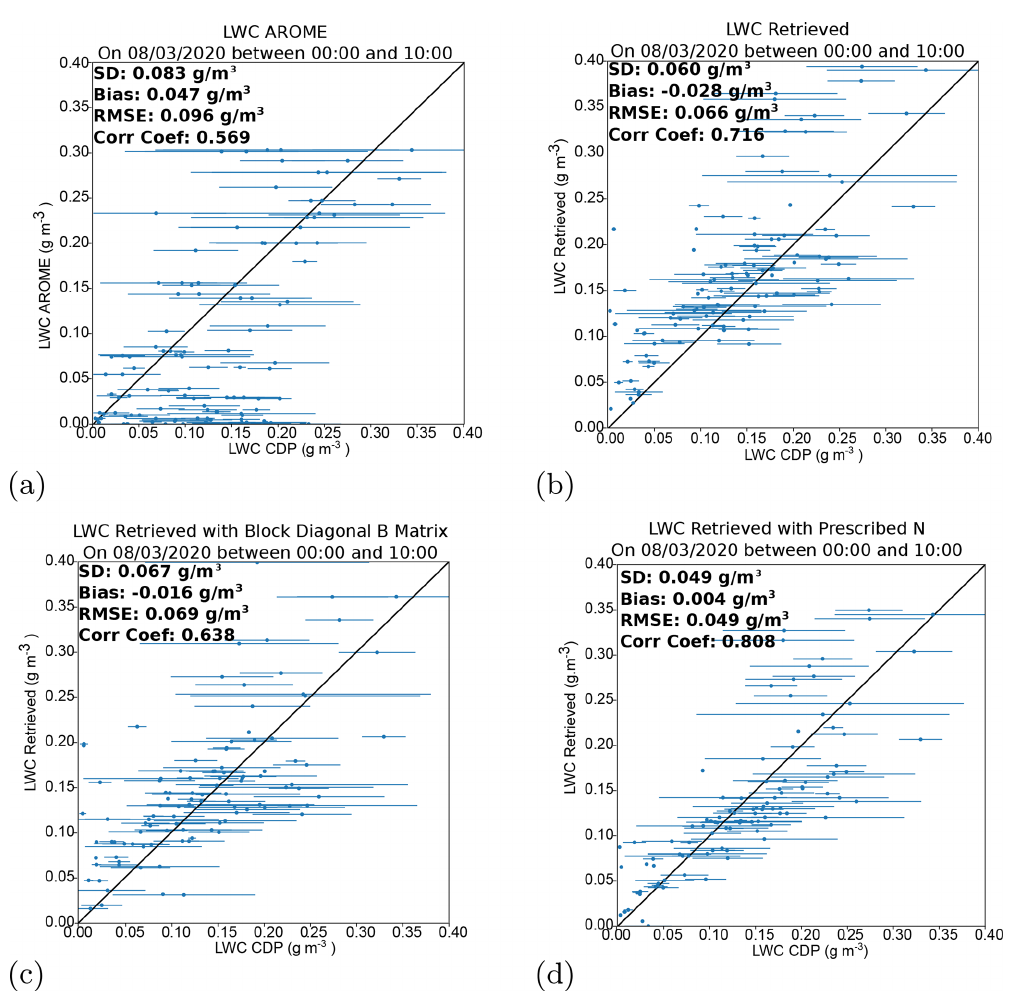
Figure 10. Scatter plots of the liquid water content (a) background and (b–d) retrieved values versus the liquid water content observed with an in situ sensor for the fog case between 01:00 and 05:00UTC on 7–8 March 2020. Panels (b–d) respectively refer to 1D-Var retrievals run with the nearest background profiles and a full fog B matrix with cross-correlations between variables, 1D-Var retrievals run with the nearest background profile and a bloc-diagonal B matrix, and 1D-Var retrievals run with the nearest background profiles and a full fog B matrix with cross-correlations and the use of the CDP droplet number concentration inside the radar simulator during the minimisation. Error bars indicate the range of in situ observations recorded throughout the height level corresponding to the retrieval height levels. The scatter plots show comparisons for all retrieval height levels between 37 and